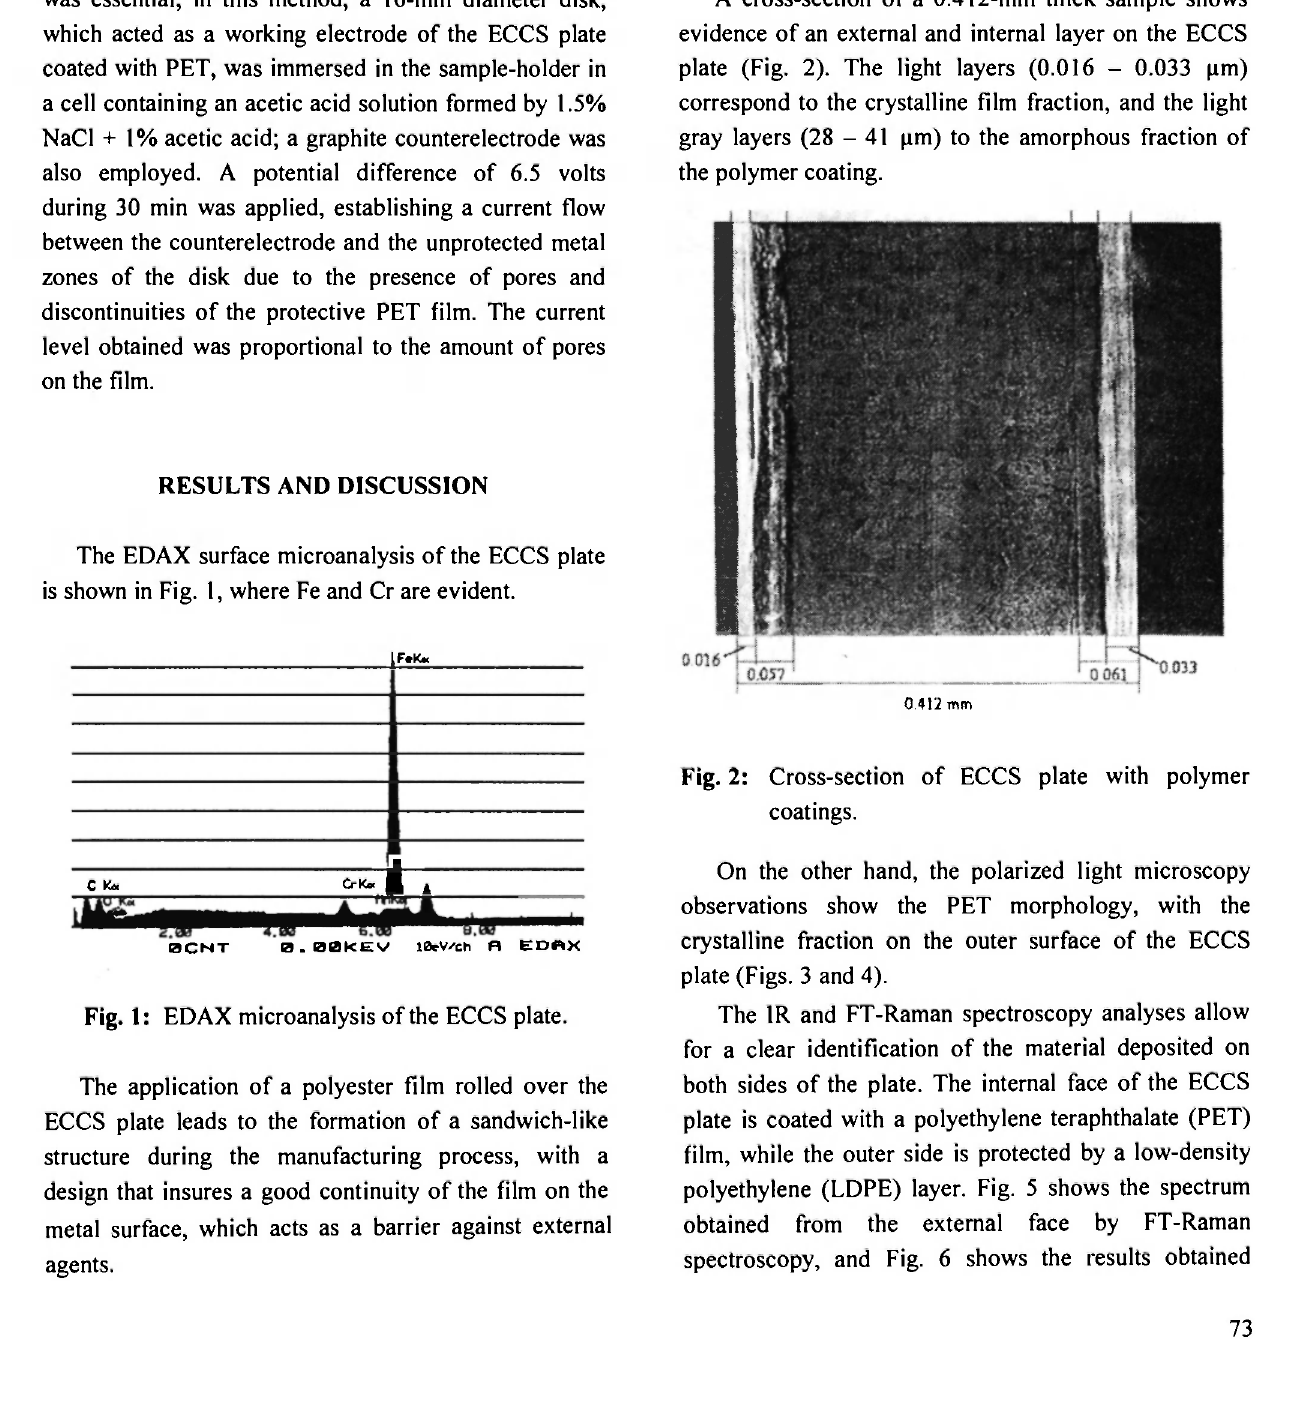
Fig. 1: EDAX microanalysis of the ECCS plate.